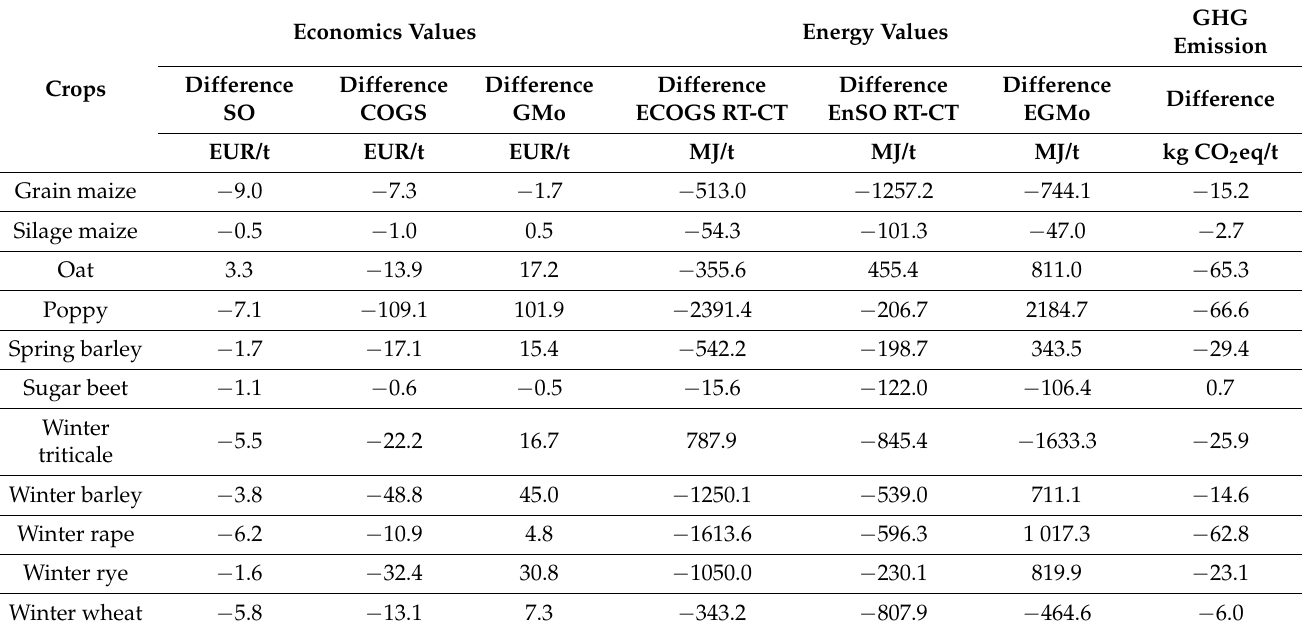
Table 3. Differences between RT and CT.